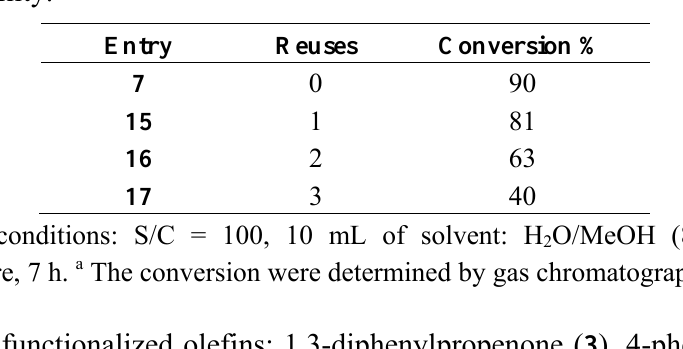
Table 2. Hydrogenation of cinnamyl alcohol catalyzed by Ni(0)-CMC-Na colloids: catalyst